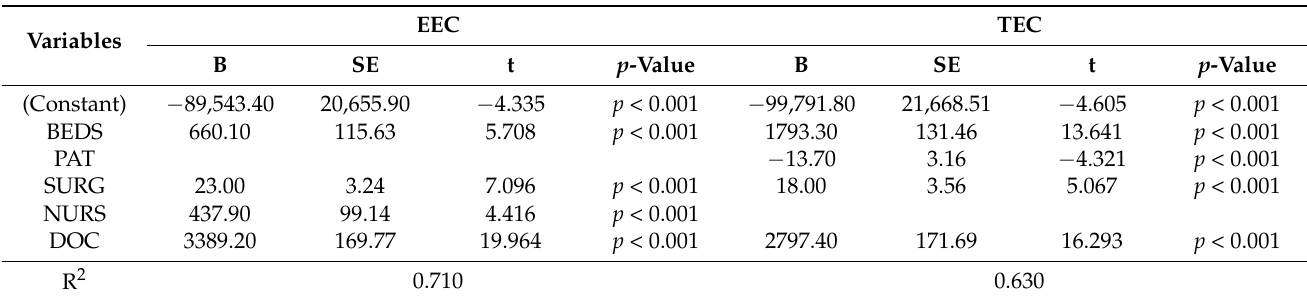
Table 4. Backward stepwise regression analysis with EEC and TEC as the dependent